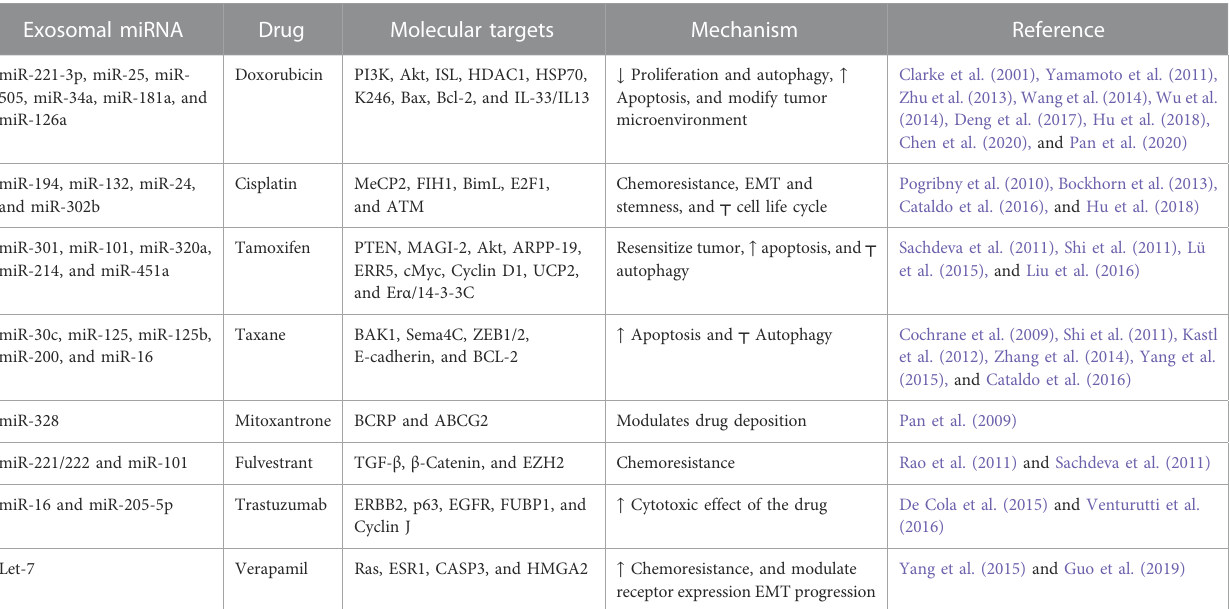
TABLE 1 Role of exosomal miRNAs in drug